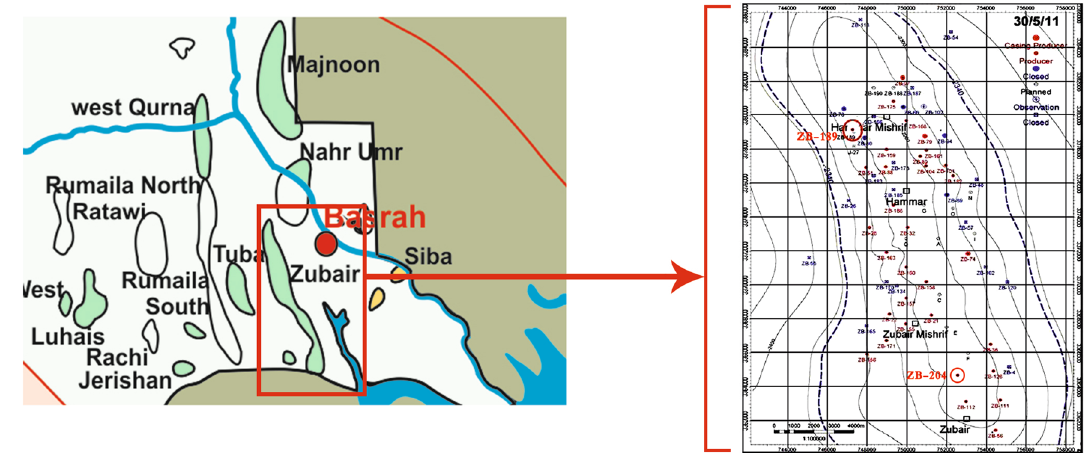
Fig. 2 Location map of Zubair oilfield and the selected wells (Al-Khafaji